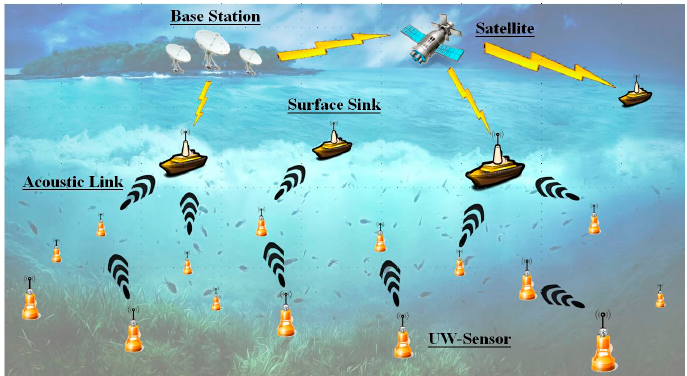
Figure 1. Underwater sensors transmit data to sinks on the surface.